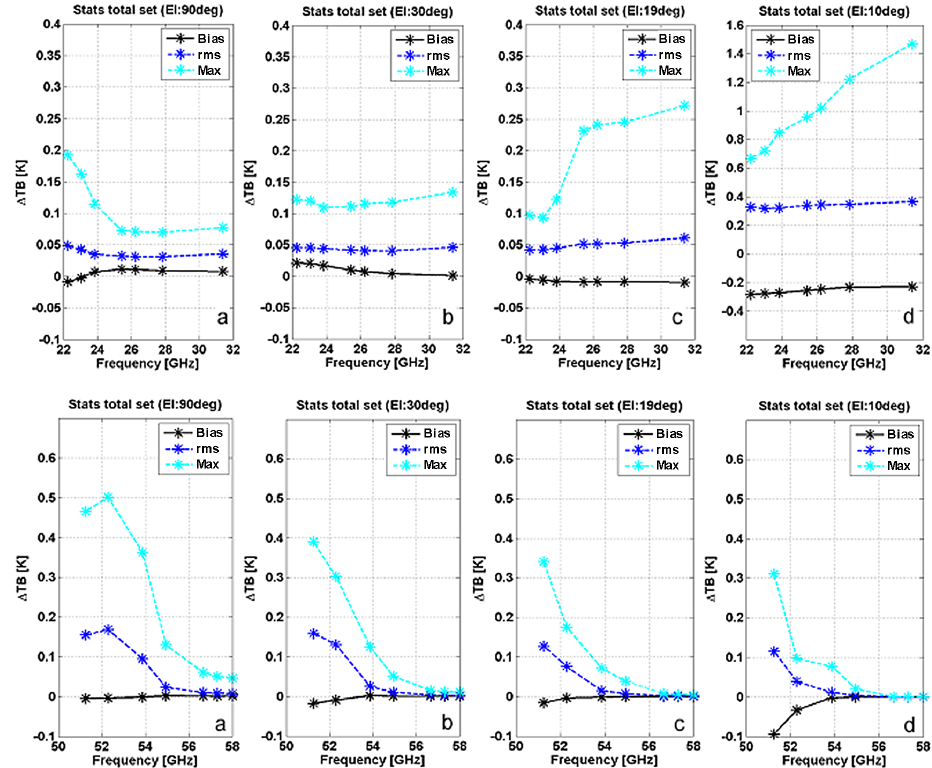
Figure 4. Same as Fig. 3 but for the independent 52-profile set (R98 minus RTTOV-gb). Top panels: K-band channels; bottom panels: V-band channels. Panels (a) , (b) , (c) , and (d) report results at 90, 30, 19, and 10 ◦ elevation angle, respectively. Note that top panel (d) has a different y axis scale to the other top